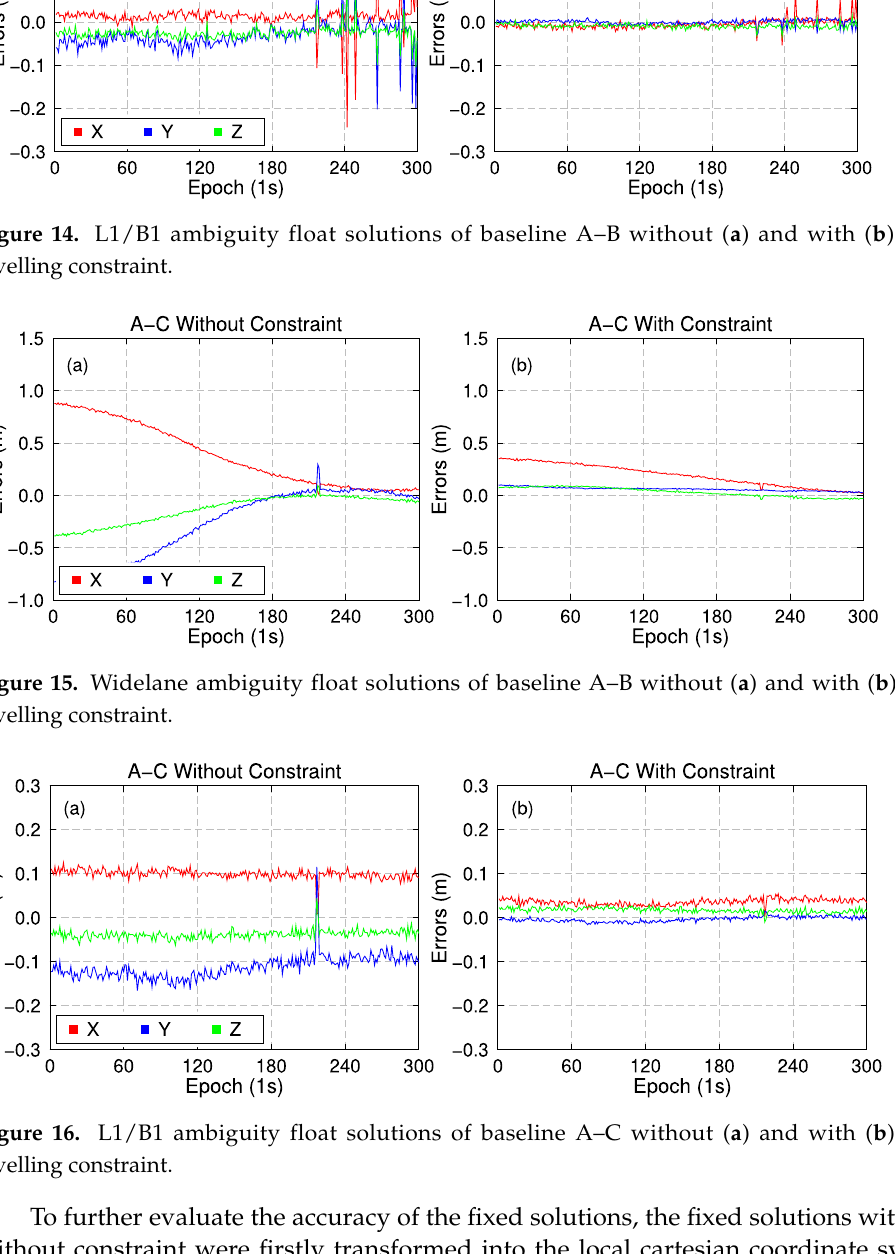
Figure 13. Widelane ambiguity float solutions of baseline A–B without ( a ) and with ( b ) static level- ling constraint.